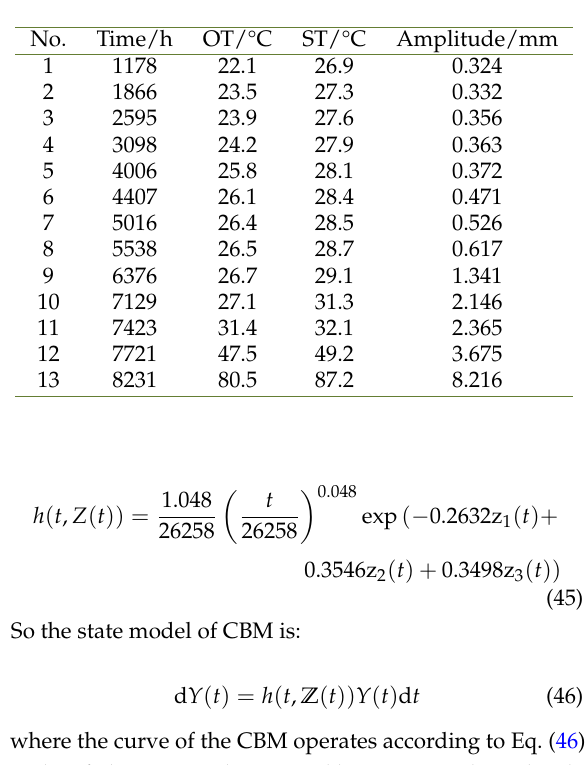
Table 2. Status monitoring value of gearbox